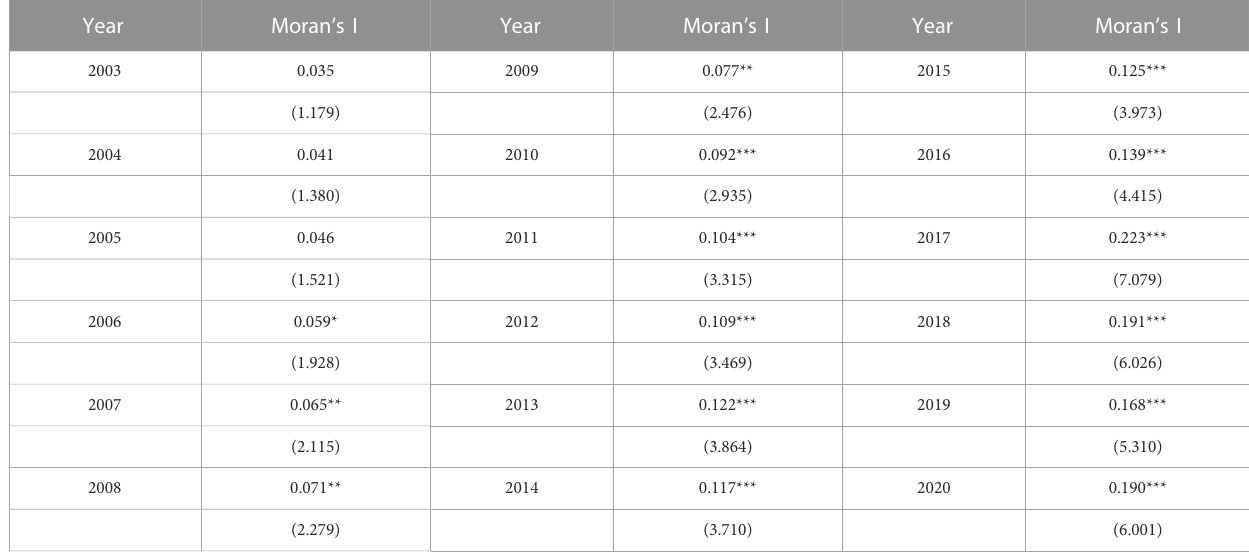
TABLE 8 Global Moran index of the coupling and coordination degree of science and technology fi nance and green